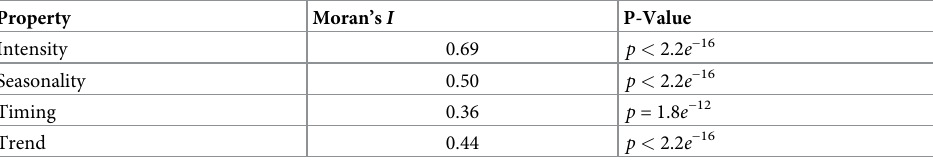
Table 2. Evidence of spatial structure by outbreak property. Moran’s I can be between -1 and 1. A positive Moran’s I indicates values are more spatially clustered than would be expected if underlying processes were random; a negative value indicates values are more spatially dispersed.